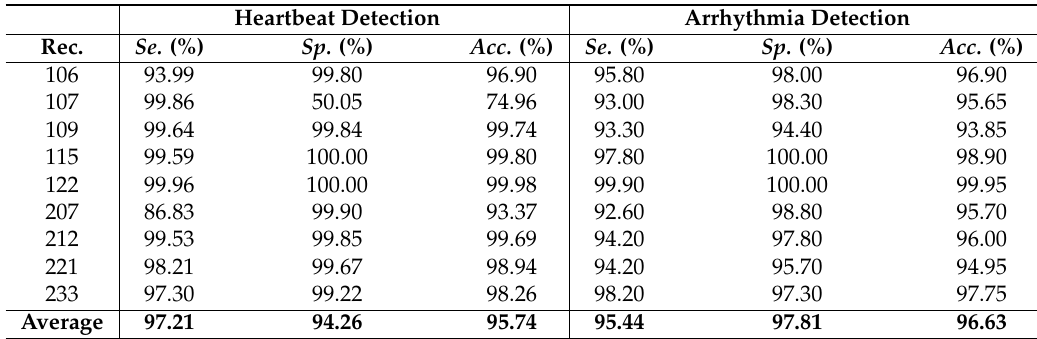
Table 6. Results of heartbeat detection and classification for arrhythmia recognition (sensitivity ( Se. ), specificity ( Sp. ) and accuracy ( Acc.